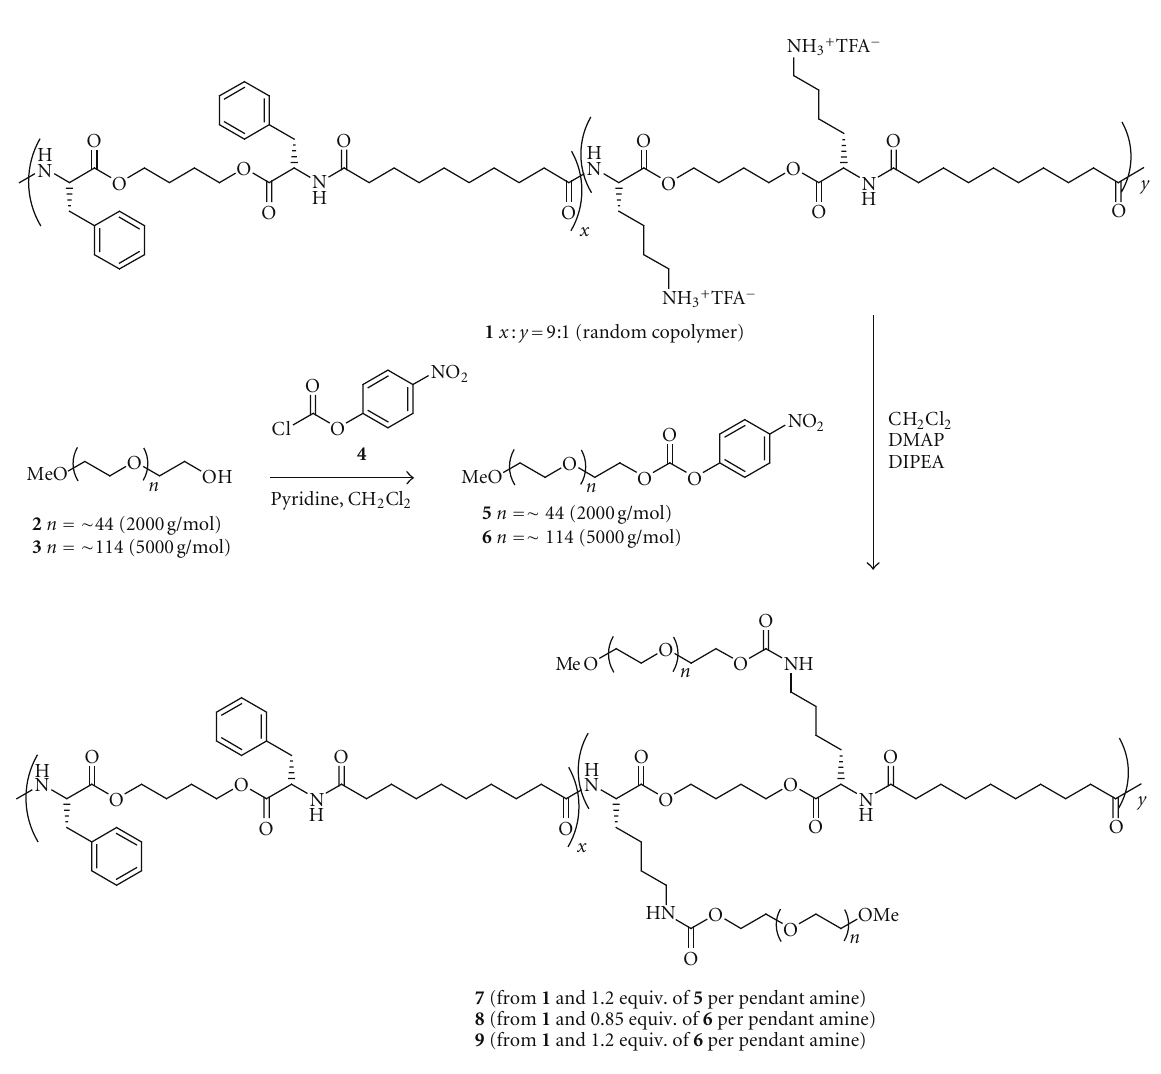
Figure 2: Synthesis of PEA-PEO graft copolymers 7 –